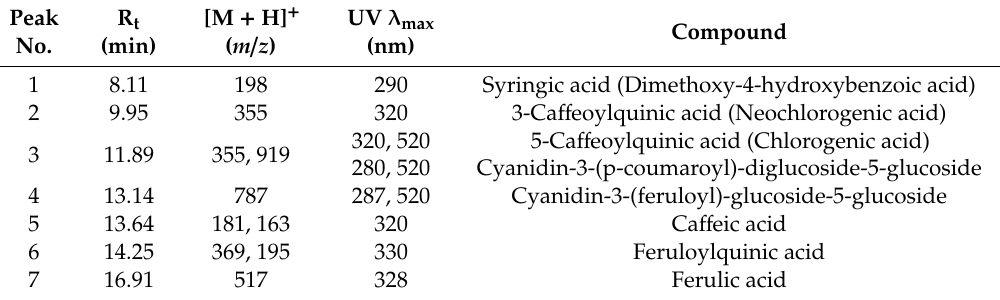
Table 7. Characterization of phenolic compounds in black carrot via positive LC-MS.